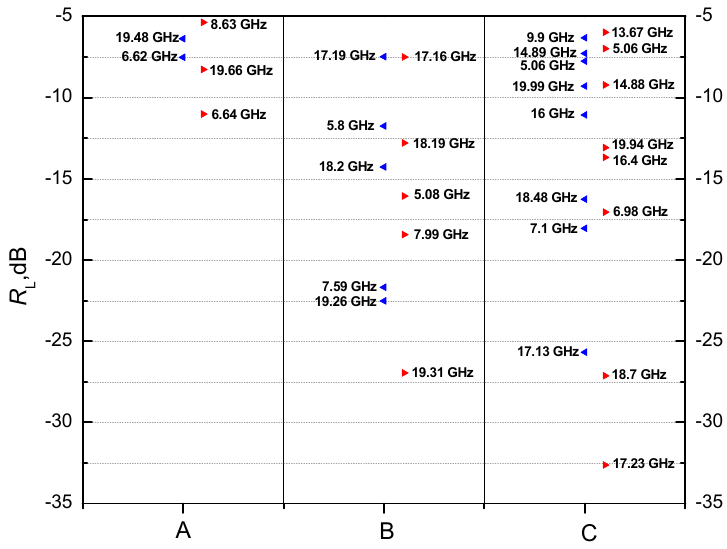
Figure 12. The main peaks (< − 5 dB) of the reflection losses R L for samples A, B and